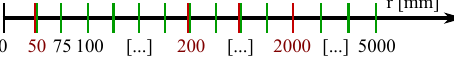
Figure 3. Relation between calibration distances (red) and measurement distances (green)